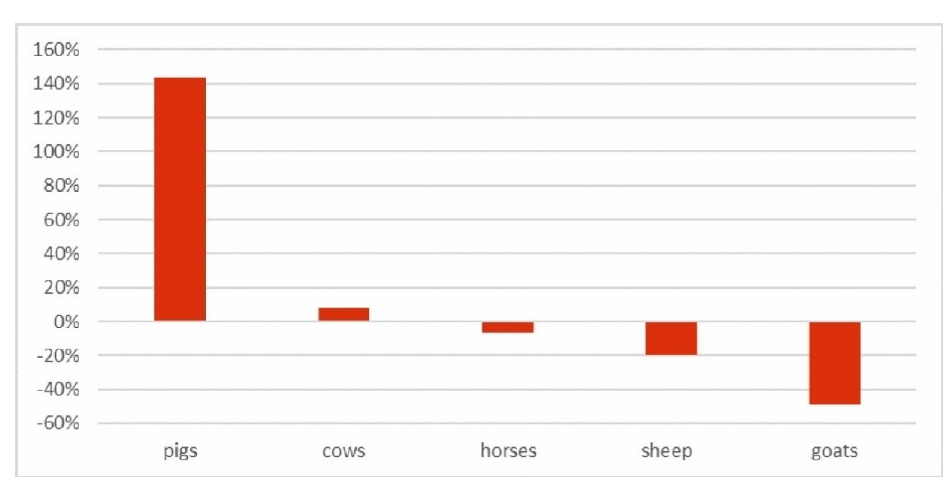
Figure 22. AMP-variation in livestock between 1990 and 2010. Source: Drawn up by the authors using data provided by the ISTAT.